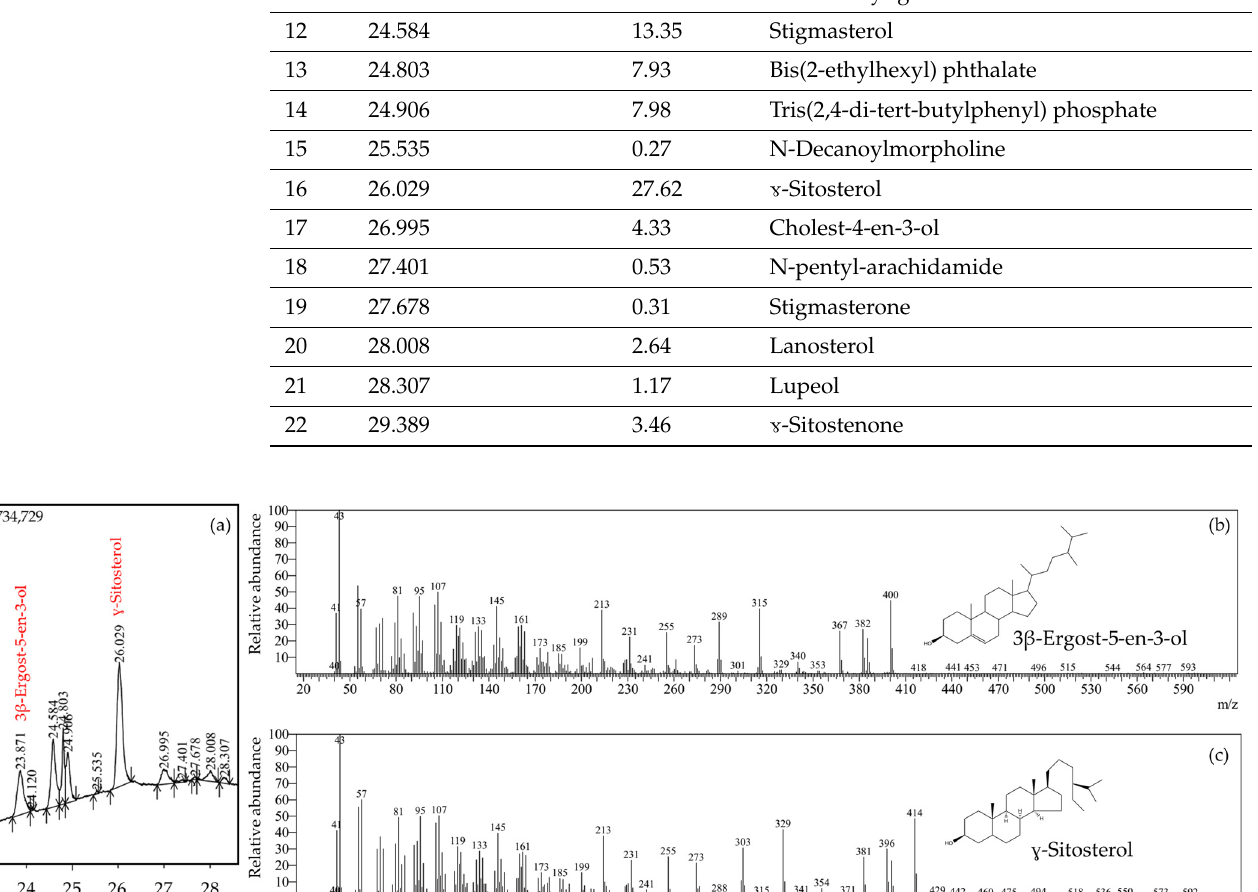
Table 1. GC-MS-based phytochemical profile of ethanolic extract from L. acidissima fruits. Peak Retention Time (min) Area (%)